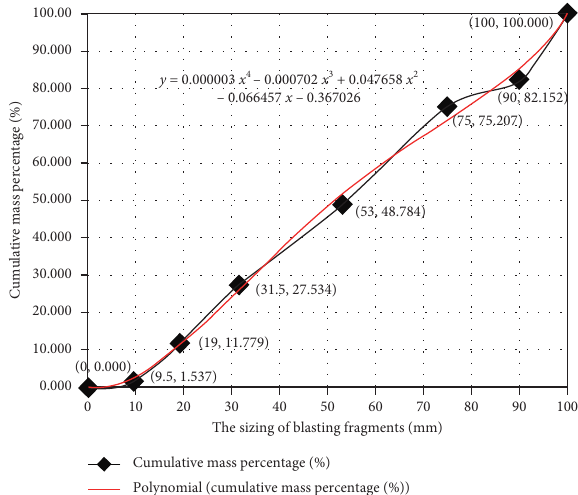
Figure 15: Relationship between cumulative mass percentage of blasting fragments and fragment size particle diameter of 69 ° wedge